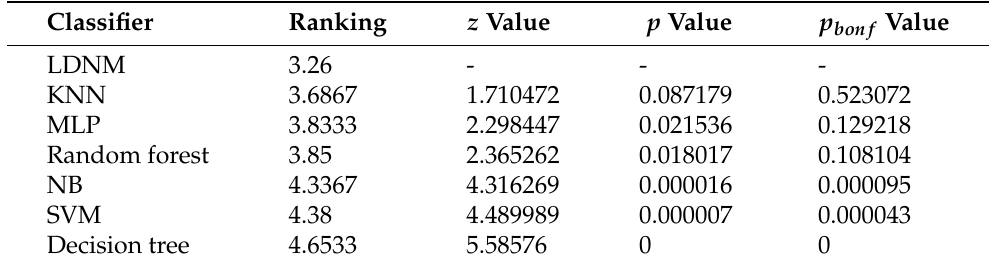
Table 7. Statistical results obtained by Friedman test on the classification accuracy in Table